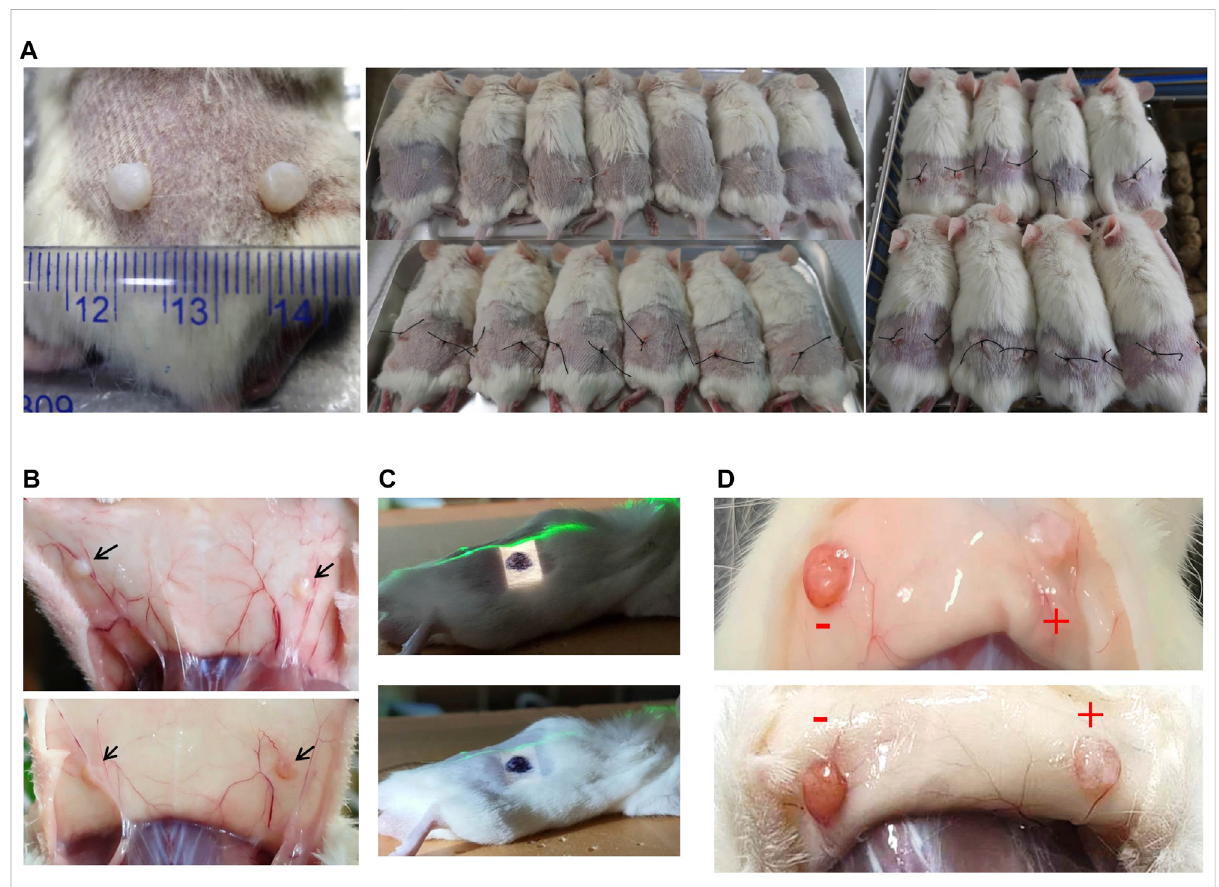
FIGURE 1 Xenotransplantation of patient-derived KS tissue in NCG mice and radiation therapy. (A) The grafts and implantation positions of the grafts are shown. (B) The grafts were visible at 20 weeks after implantation without irradiation. Representative images are shown. (C) Image of the fi eld irradiatedwithanelectronbeam.Therightsideofthegraftismarkedinblack.Thegreenlineisthelaseralignmentline. (D) Oneweekafterirradiation, graft morphological alterations were observed. Representative images are